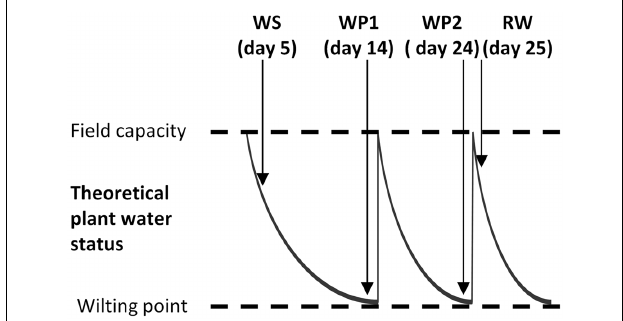
FIGURE 1 | Schematic diagram of watering regime for wheat cyclic drought experiment. Abbreviations:WS, water stressed at day 5;WP1, first wilting point of intolerant cultivar at day 14;WP2, second wilting point of intolerant cultivar at day 24; and RW, re-watered at day 25.